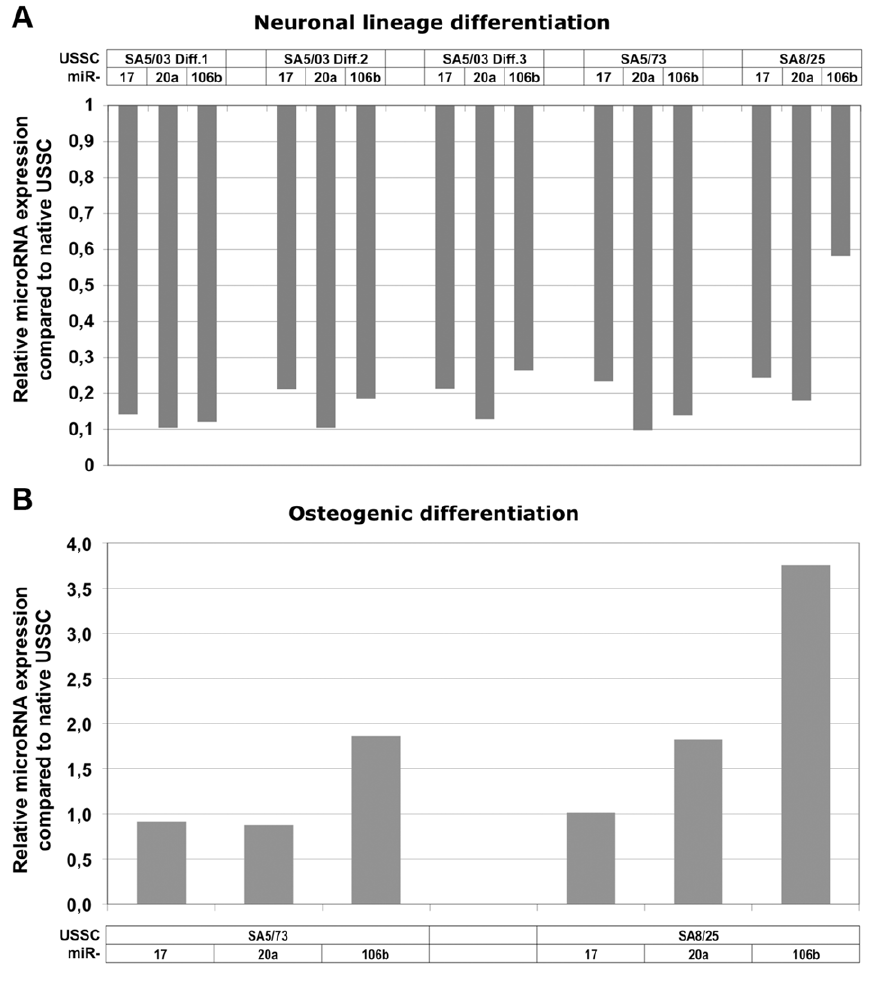
Figure 1. Differential expression of miR-17, miR-20a, and miR-106b in USSC differentiating in neuronal and osteogenic lineages. USSC lines SA5/03, SA5/73, and SA8/25 were differentiated into neuronal lineage for 14 days (SA8/25: 28 days) and USSC lines SA5/73 and SA8/25 were differentiated into osteogenic lineage for 7 days. MicroRNA expression profiles were analyzed from native USSC lines as well as from USSC differentiated into both lineages using the TaqMan microRNA Megaplex array. Fold expression changes (2 2 ddCt -values) are given for microRNAs miR- 17, miR-20a, and miR-106b. (A) Downregulation of miR-17, miR-20a, and miR-106b during neuronal lineage differentiation of USSC. Individual results from overall 5 independent neuronal lineage differentiation approaches of USSC lines SA5/03, SA5/73 and SA8/25 are given. MicroRNAs miR-17, miR- 20a, and miR-106b were found consistently downregulated in all USSC lines differentiated into cells of neuronal lineage. (B) Expression of miR-17, miR-20a, and miR-106b during independent osteogenic differentiations of USSC lines SA5/73 and SA8/25. In contrast to the neuronal lineage differentiations, expression of miR-17, miR-20a, and miR-106b remained unchanged or was slightly upregulated after 7 days of osteogenic differentiation. doi:10.1371/journal.pone.0016138.g001 target for miR-17 [36]. MAPK9 inhibits the cyclin D1/CDK4/6 activator JUN [51]. For experimental target gene validations, full- length 3 9 -UTRs or fragments of 3 9 -UTRs (see Table S1) of transcripts of proteins of interest were cloned at the C-terminus of Firefly luciferase present in dual luciferase ( Firefly/Renilla ) reporter vector pmirGLO. Pairs of empty pmirGLO and pmirGLO/3 9 - UTR were cotransfected into HEK293T cells with miR-17, -20a, or -106b microRNA-mimics to test for specific influence of the microRNA on the given 3 9 -UTR. Firefly activities were normalized to effects caused by (i) endogenous HEK293T microRNAs on the 3 9 UTRs cloned (miR-17, miR-20a, and miR-106b and homologs are highly expressed in HEK293T cells [52]), (ii) unspecific effects of certain microRNA-mimics on Firefly and Renilla activity per se , and (iii) transfection efficiency variations. Percent reductions of normal- ized Firefly activities of co-transfections of each mimic with pmirGLO/3 9 -UTR compared to pmirGLO are given in Fig. 2A–